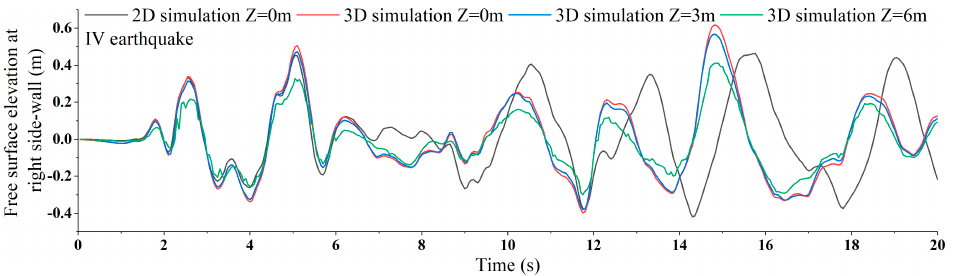
Figure 8. Free surface elevations at the right side wall.